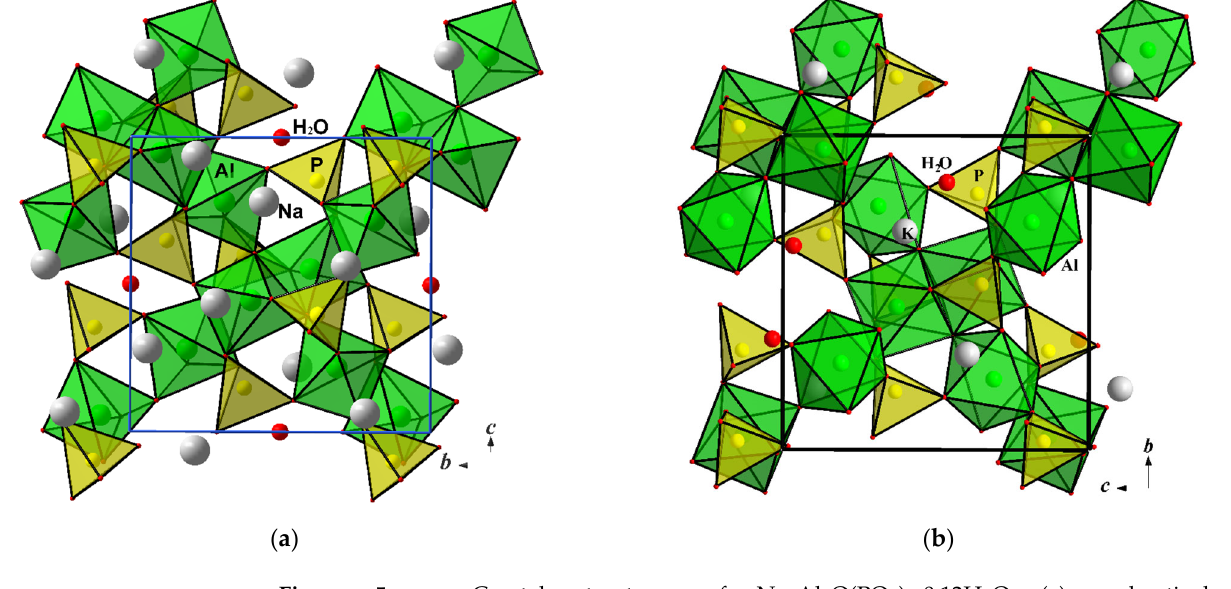
Figure 5. Crystal structures of Na 2 Al 2 O(PO 4 ) 2 ∙ 0.12H 2 O ( a ) and tinsleyite, KAl 2 (OH)(H 2 O)(PO 4 ) 2 ∙ H 2 O ( b ) projected along the a axis.